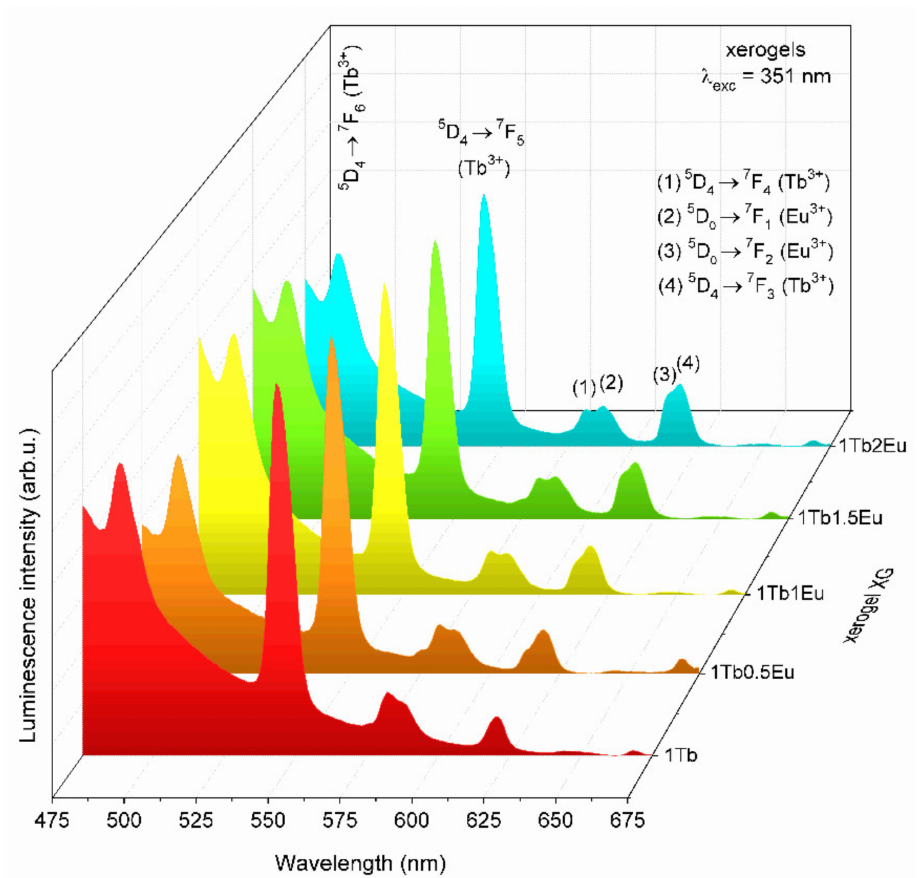
Figure 8. The emission spectra of XG 1Tb and XG 1TbxEu xerogels recorded under excitation at λ exc = 351